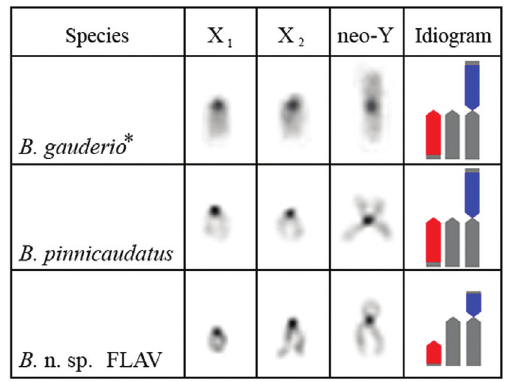
Figure 5 - Morphology of the sex chromosomes in the genus Brachyhypopomus .*SpeciesanalyzedbyAlmeida-Toledo etal.